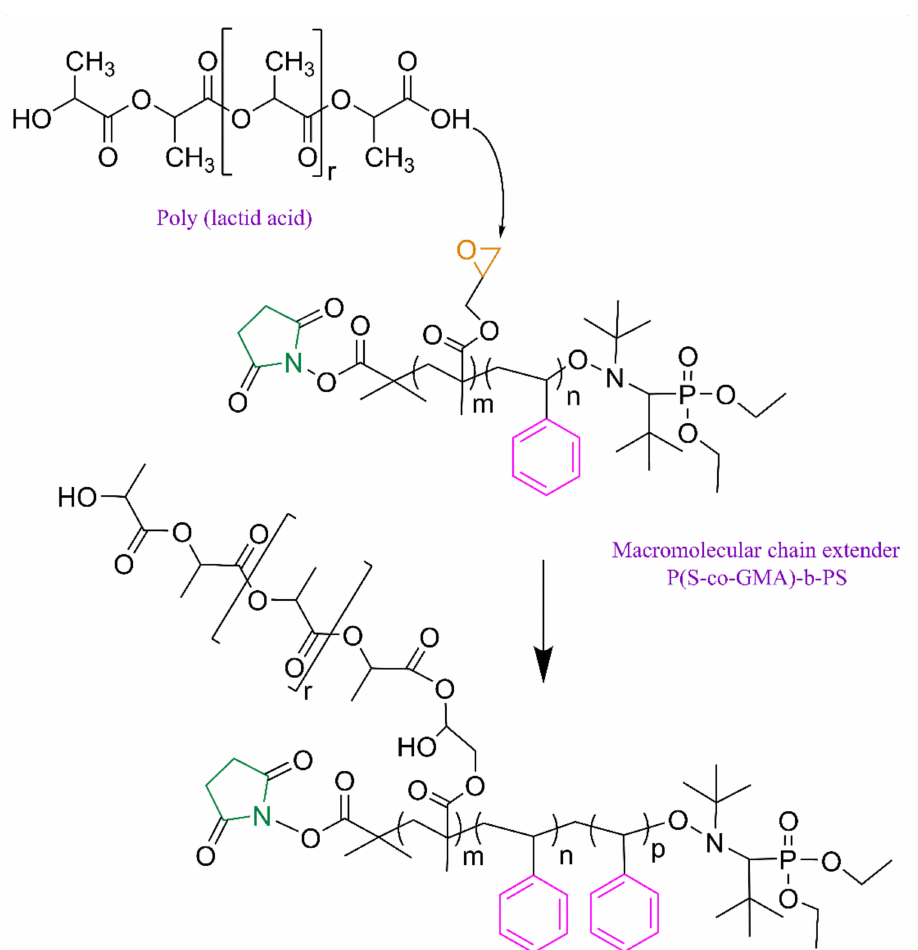
Figure 2. Polymerization scheme for the NMP synthesis of P(S-co-GMA)-b-PS copolymers using